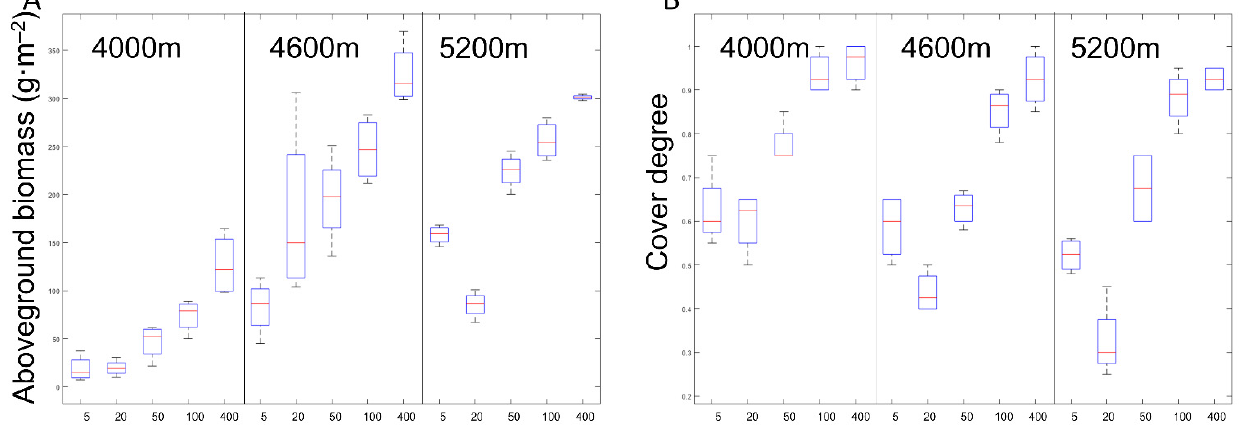
Figure 2. Comparison of ( A ) above-ground biomass, ( B ) plant cover degree, ( C ) plant simpson and ( D ) above-ground biomass between treatments at 5, 20, 50, 100 and 400 m from the curb G109 highways at altitudes of 4000 m (L), 4600 m (M) and 5200 m (H). The soil moisture (SM) was significantly reduced by 58.63%, 38.45%, and 73.04% within 100 m along the highway at 20 m plots from the highway in 4000 m, 4600 m, and 5200 m sites, respectively (Figure 3A). In the 5200 m site, soil pH significantly decreased by 6.26%, 6.07%, 3.47%, and 2.11% at 5 m, 20 m, 50 m, and 100 m from the road, respec- tively (Figure 3B). At the same time, smaller changes occurred at 4000 m and 4600 m, with only significant decreases of 2.75% and 1.29% at 5 m from the road, respectively. The soil temperature in the areas 100 m and 50 m away from the highway decreased significantly compared with the control, 4000 m site and 5200 m site, respectively (Figure 3C). Soil com- paction only changed significantly at 5200 m and decreased by 9. 14% (1715.75 Pa) and 5.69% (1780.75 Pa) at 5 m and 20 m away from the road, respectively (Figure 3D). SOC is negatively related to the distance from the road. This trend is most obvious at 5200 m (Figure 4A). Roads significantly reduced soil organic carbon by 33.85% (.84 g·kg − 1 ), 36.43% (8.49 g·kg − 1 ), and 32.72% (8.99 g·kg − 1 ) at plots 5 m, 50 m, and 100 m away from the road, respectively. Soil organic carbon content decreased by 70.19% (8.35 g·kg − 1 ) and 66.01% (9.52 g·kg − 1 ) at 5 m and 20 m plots from the road, respectively, compared with the control (400 m) at 5200 m. Soil total nitrogen content decreased by 67. 48%, 60.98%, 19.86% and 21.12% at 5 m, 20 m, 50 m, and 100 m away from the highway, respectively (Figure 4B). In the 4600 m site, soil total nitrogen content significantly decreased by 27.17% at 20